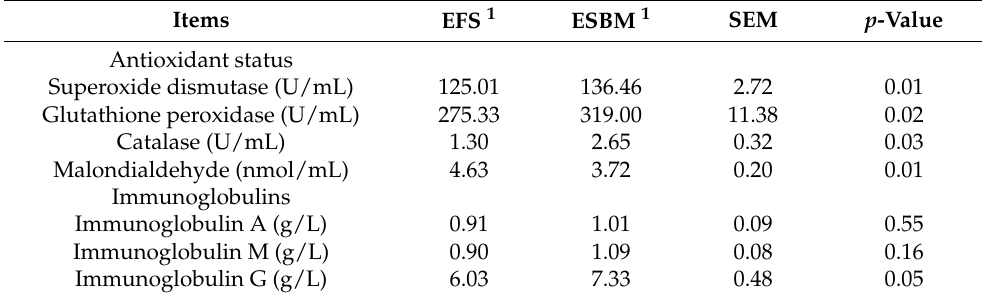
Table 3. Effects of enzyme-treated soybean meal replacing extruded full-fat soybean on serum antioxidant status and immunoglobulins in nursery